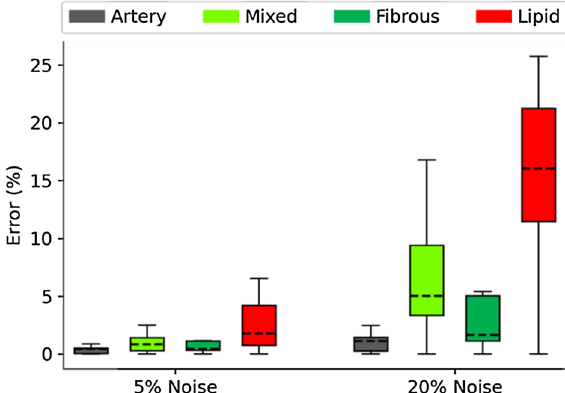
Figure 5. Errors in linear elastic parameter recovery when 5% and 20% Gaussian noise were imposed to generate noisy target